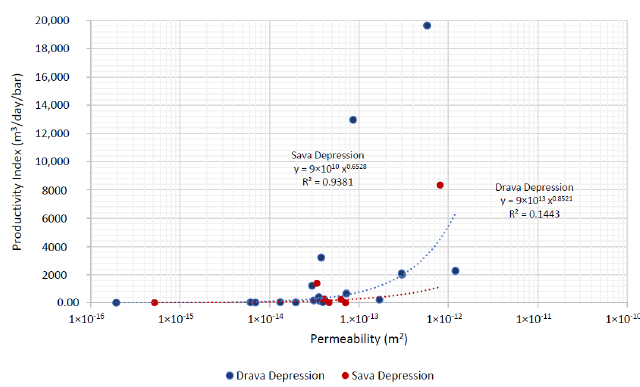
Figure 5. PI vs. Permeability data correlation—pre-rift phase.